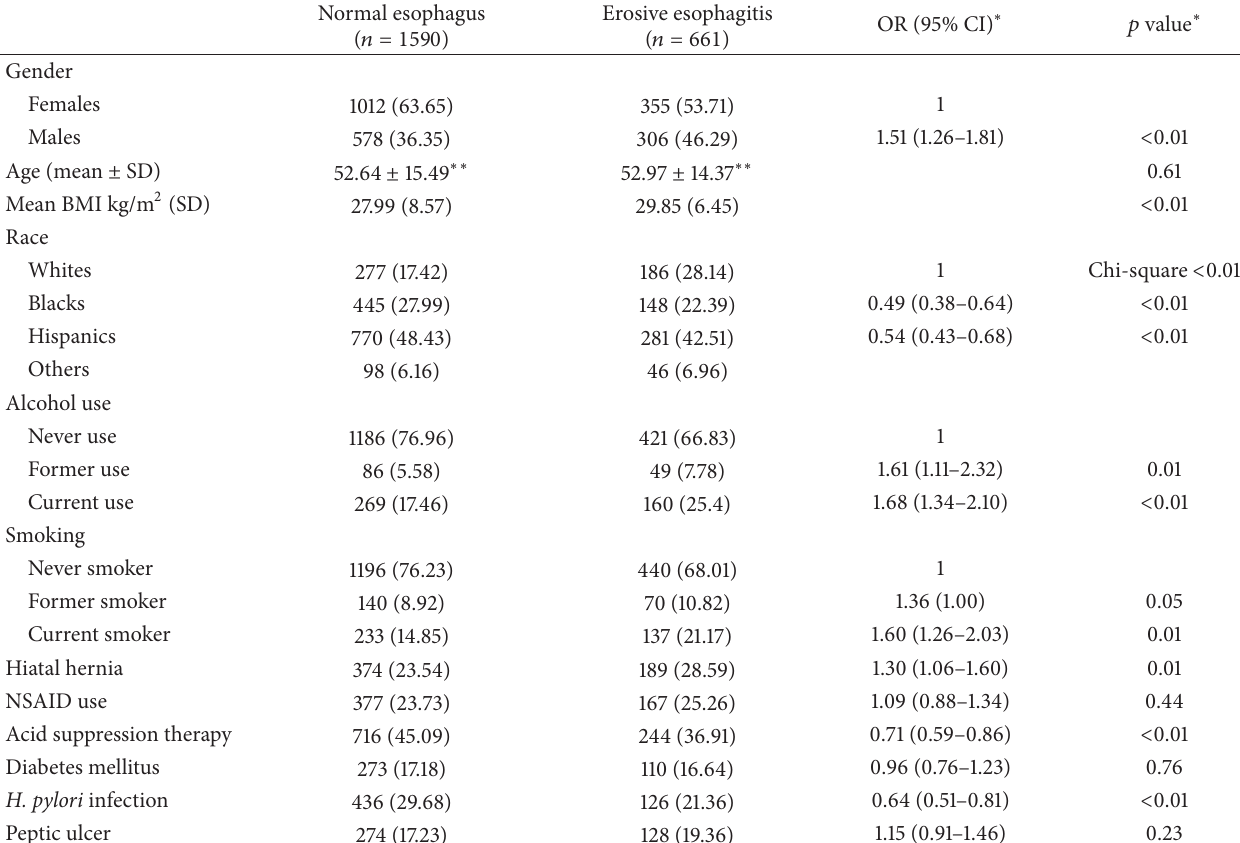
Table 1: Comparisons of patient characteristics based on endoscopic presence of erosive esophagitis.